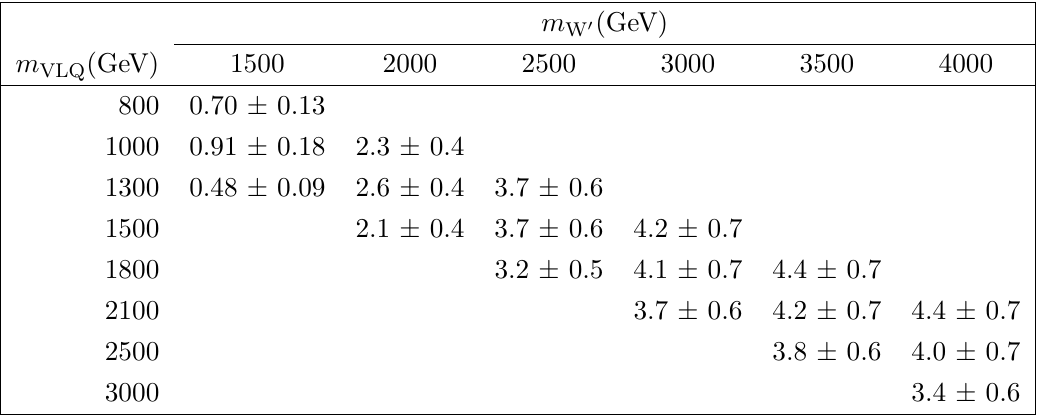
Table 2 . The selection e(cid:14)ciency (%) for each signal mass point in the